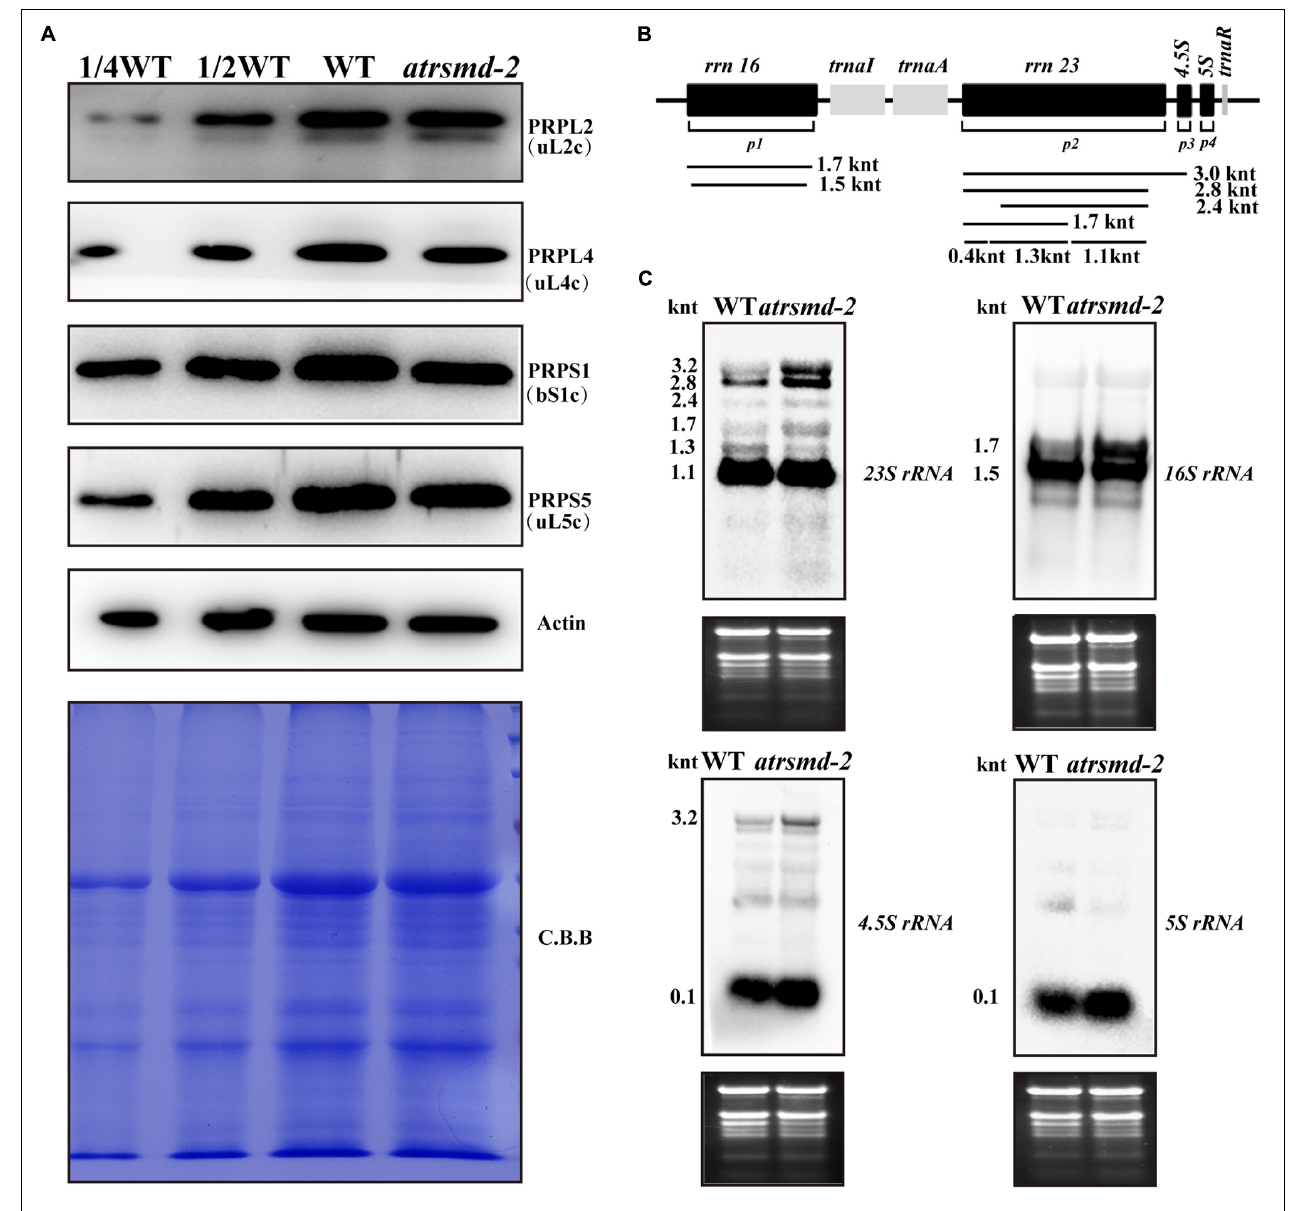
FIGURE 6 | Accumulation of chloroplast ribosomal proteins and rRNAs in the wild type and atrsmd-2 mutant grown under normal conditions. (A) Immunoblot analysis of the chloroplast ribosomal proteins from the wild type (WT) and atrsmd-2 mutant was performed. PRPS1/bS1c,PRPS5/uS5c, PRPL4/uL4c, and PRPL2/uL2cwere checked in the wild type and atrsmd-2 mutant. Total proteins from the WT samples were loaded at three different concentrations (2.5, 5, and 10 µ g), and total proteins from the mutant samples were loaded at 10 µ g. (B) Schematic diagram of Arabidopsis chloroplast rRNA operon and the probe positions used RNA gel blot analyses. Sizes of different transcript forms of chloroplast rRNA are indicated below the diagram. p1, p2, p3, and p4 indicate positions of the probes for 16S rRNA , 23S rRNA , 4.5S rRNA , and 5S rRNA , respectively. (C) RNA gel analysis of chloroplast rRNA s in the wild type and atrsmd-2 mutant. Five micrograms of total RNA was loaded in each lane with the corresponding probes as shown above. Total RNA was stained with ethidium bromide (EtBr) and used as a loading control. The sizes of different transcript forms of chloroplast rRNAs are